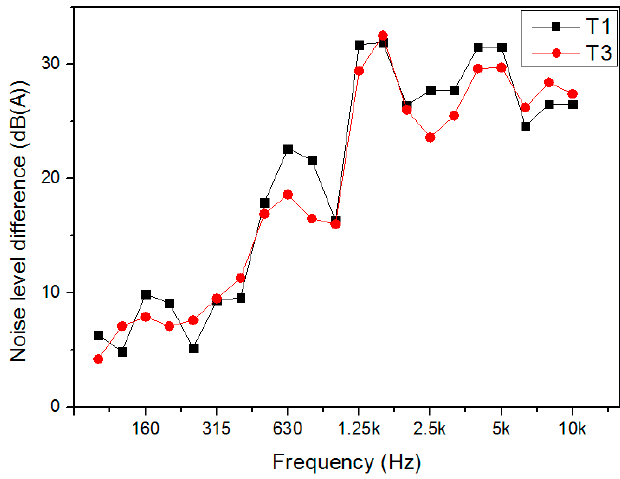
Figure 6. Difference of sound pressure levels between S1 and S2 experiment points.